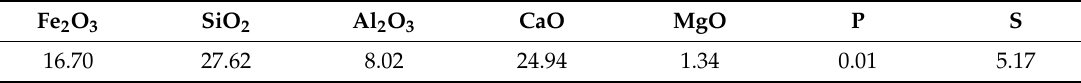
Table 3. Main chemical composition of coal ash/wt. %.